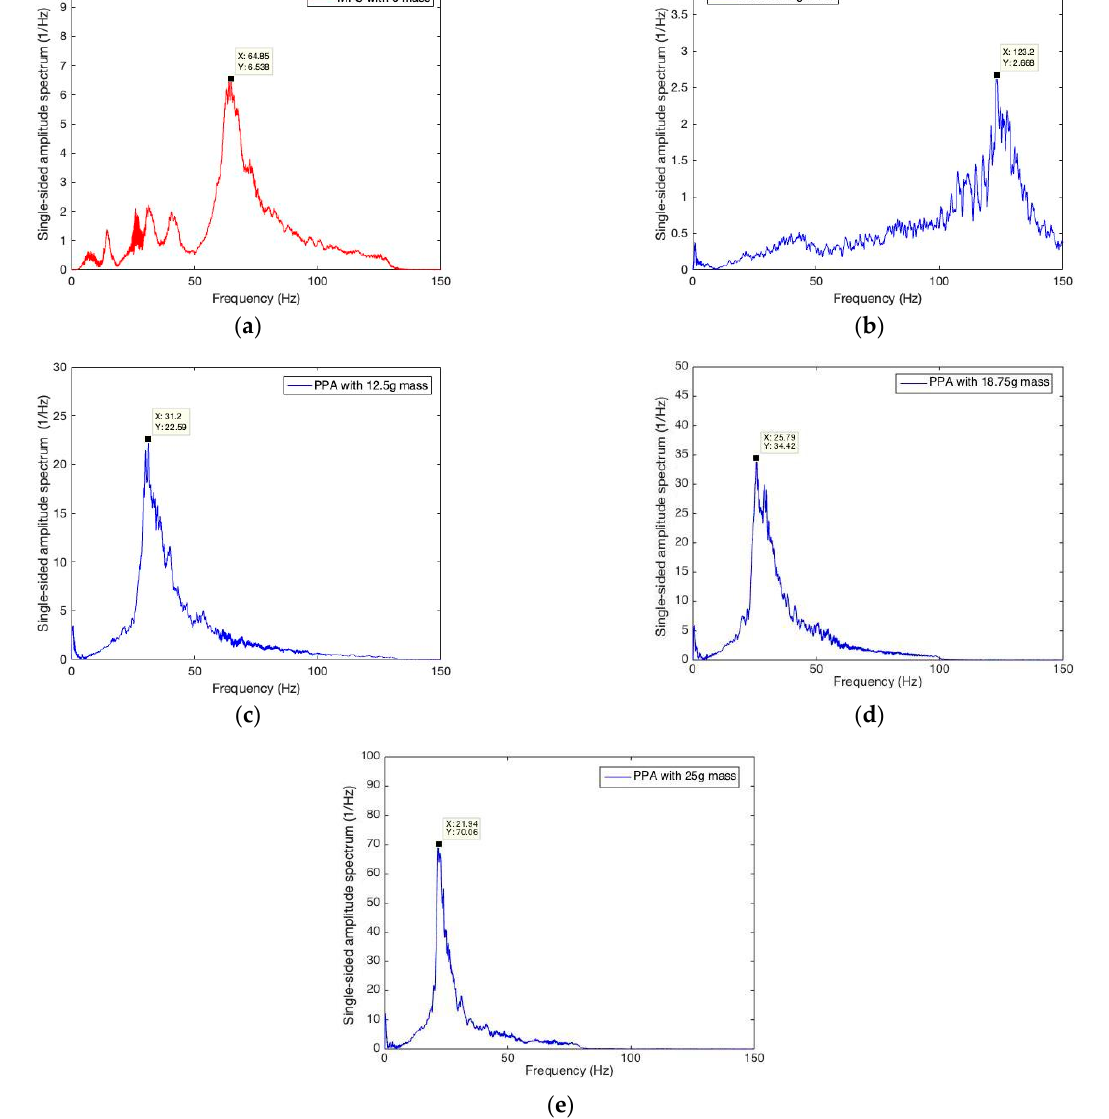
Figure 4. Amplitude spectrum of frequency sweep for the strain response of PPA and MFC. ( a ) Amplitude spectrum for MFC with 0 g mass; ( b ) Amplitude spectrum for PPA with 0 g mass; ( c ) Amplitude spectrum for PPA with 12.5 g mass; ( d ) Amplitude spectrum for PPA with 18.75 g mass; ( e ) Amplitude spectrum for PPA with 25 g